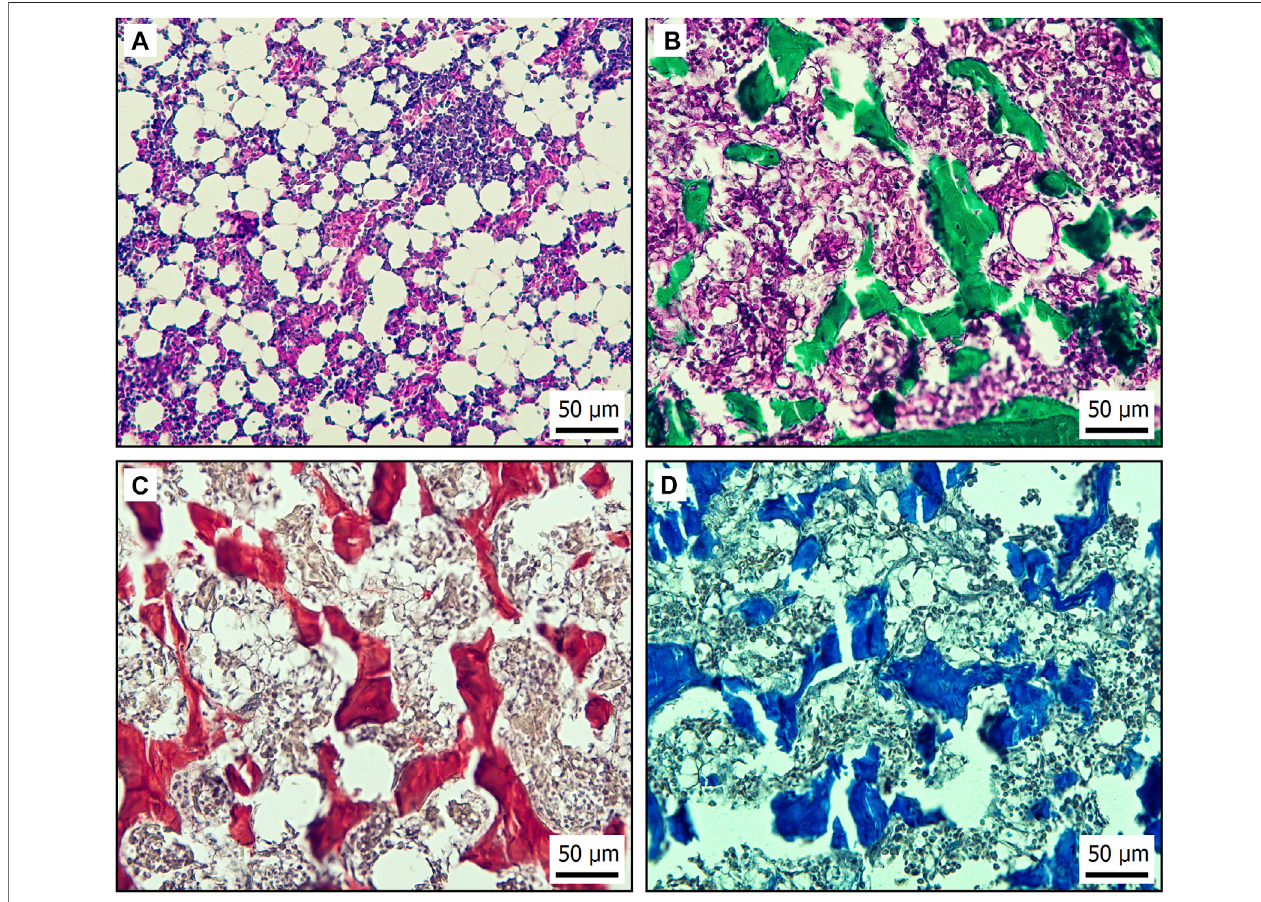
FIGURE2| Histologicalbonemarrow specimensfromlayinghenaged21 weeks. (A) H&Estainingofvascularnicheinbonemarrow. (B) Endostealregionofbone marrow stained by Masson ’ s green trichrome to demonstrate connective tissue based on collagen (green). (C) Sirius red staining of collagen type I (red) in endosteal niche of bone marrow. (D) Endosteal niche of bone marrow stained by Alcian blue to recognize hyaluronic acid (blue) in extracellular matrix.